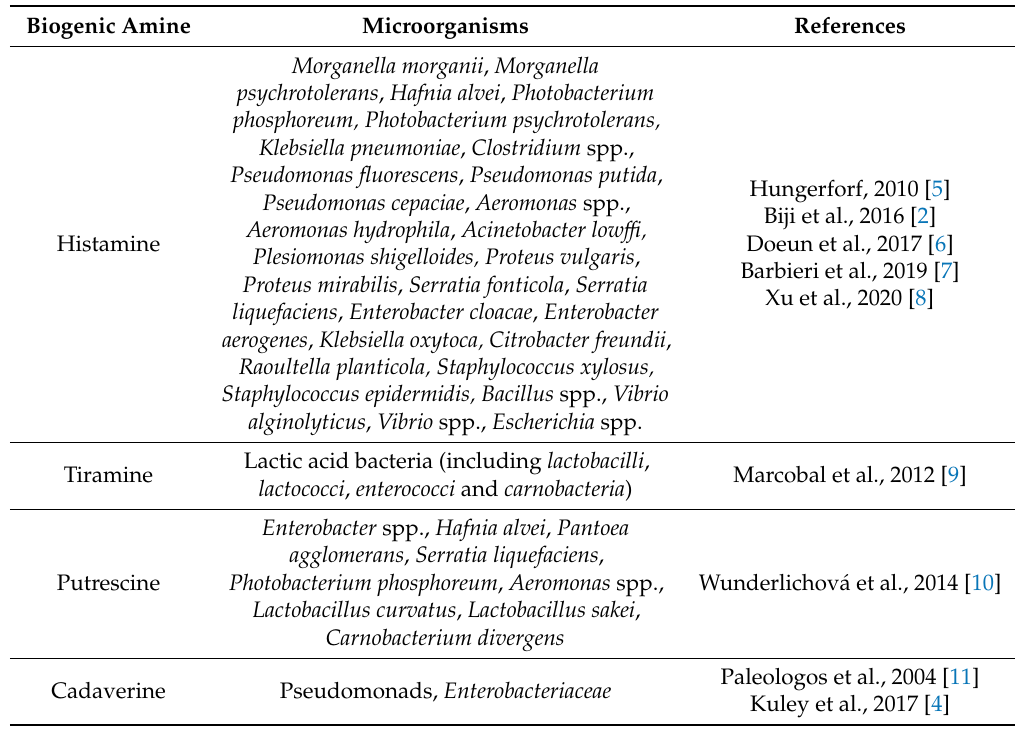
Table 2. Microorganisms producing biogenic amines in